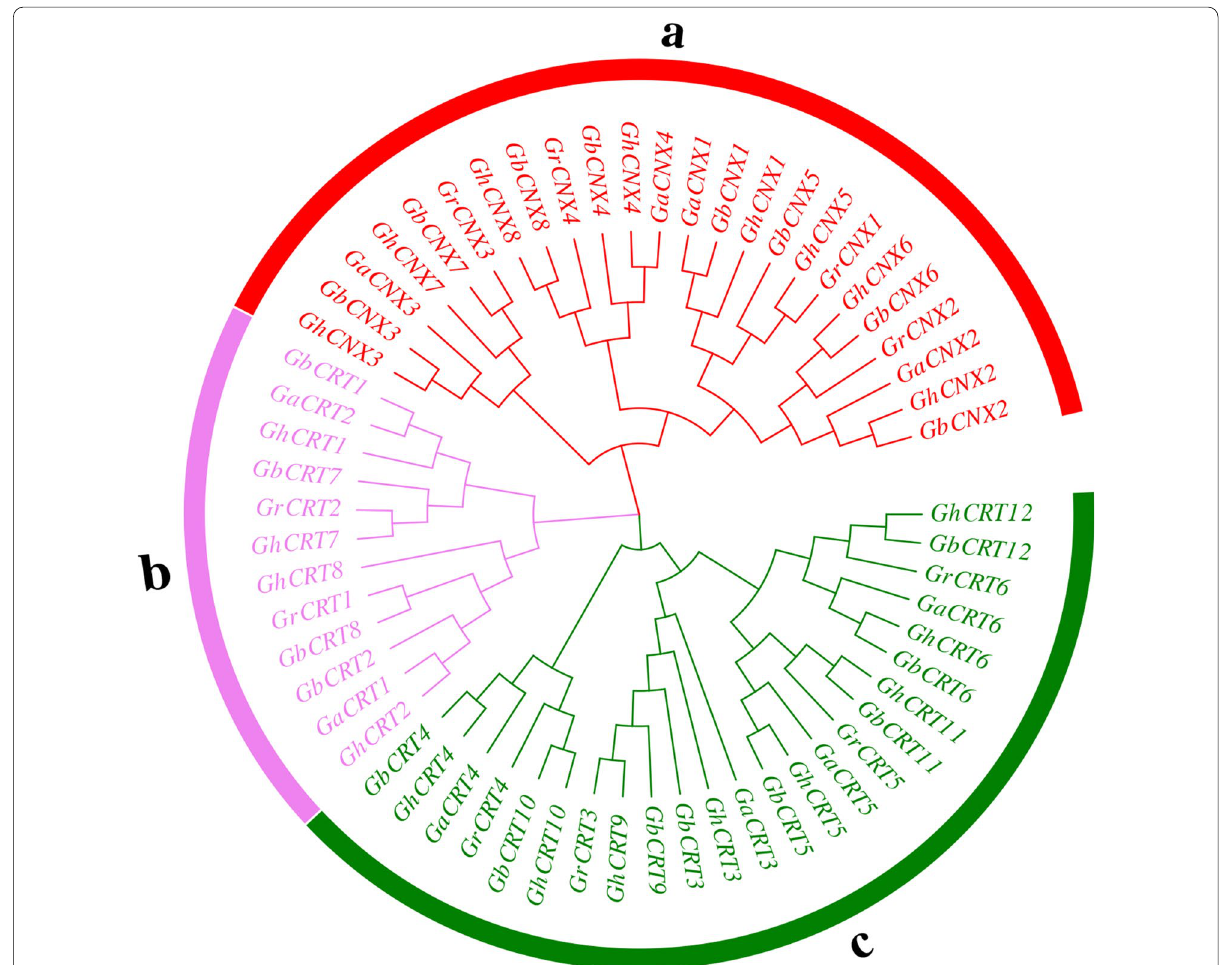
Fig. 1 Phylogenetic tree analysis of CNX family genes within four Gossypium species. The phylogenetic tree of four Gossypium species was constructed by the neighbor-joining